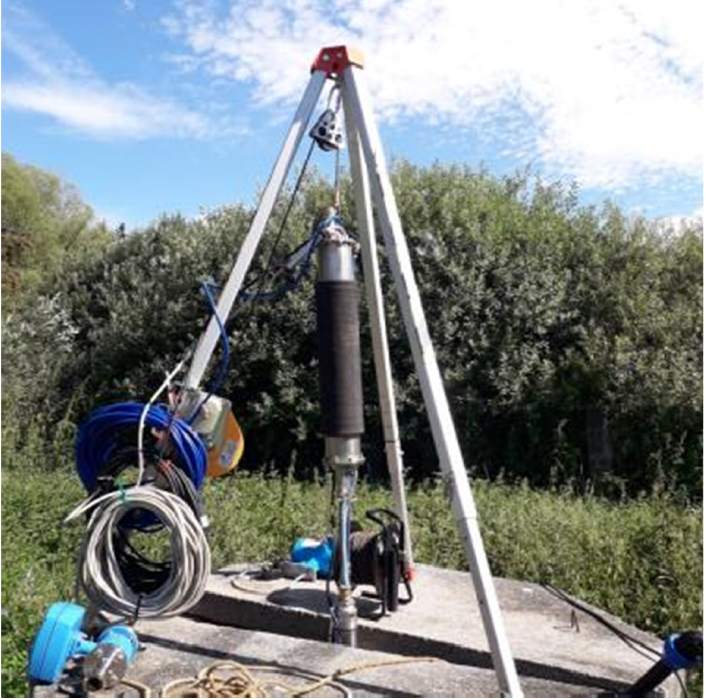
Figure 11. The INV-FLOW apparatus during installation in the measured extraction well HJ-3 at the pilot site.